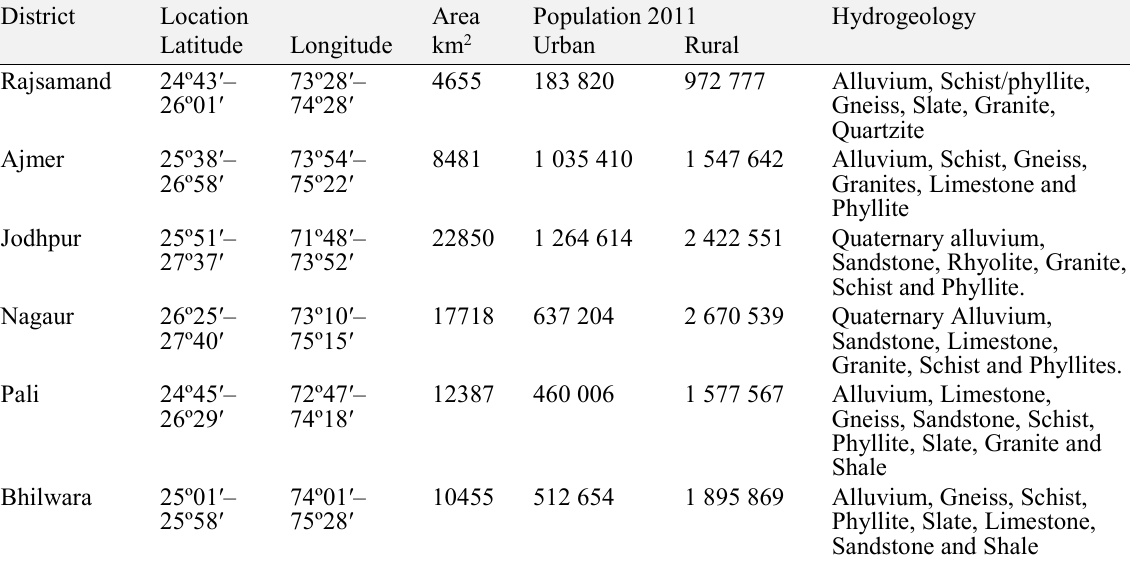
Table 1 Detail of the study area (physical, geological and hydrogeological) .